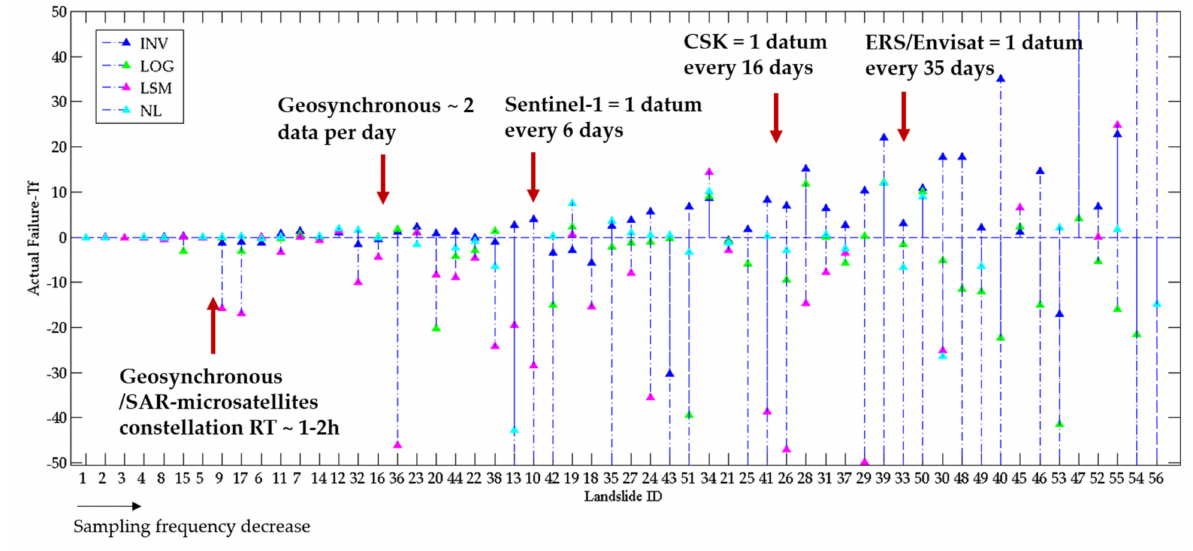
Figure 18. Error diagram comparing the errors of failure prediction (y-axis) and data sampling frequency (x-axis). The sampling frequency of datasets decreases towards the right, passing from a sampling frequency of about one datum per minute (ID 1) to one datum every three months (ID 56). The diagram shows the error of predictions (y-axis) obtained with different landslide forecasting methods. The colours identify the different failure forecasting methods (FFMs). The red arrows identify the points corresponding to the sampling frequency of: Future geosynchronous SAR or SAR microsatellite constellation (revisit: 1–2 h), single geosynchronous SAR (revisit: 12 h), Sentinel-1 (revisit: Six days), COSMO-SkyMed (revisit: 16 days) and ERS and Envisat satellites (revisit: 35